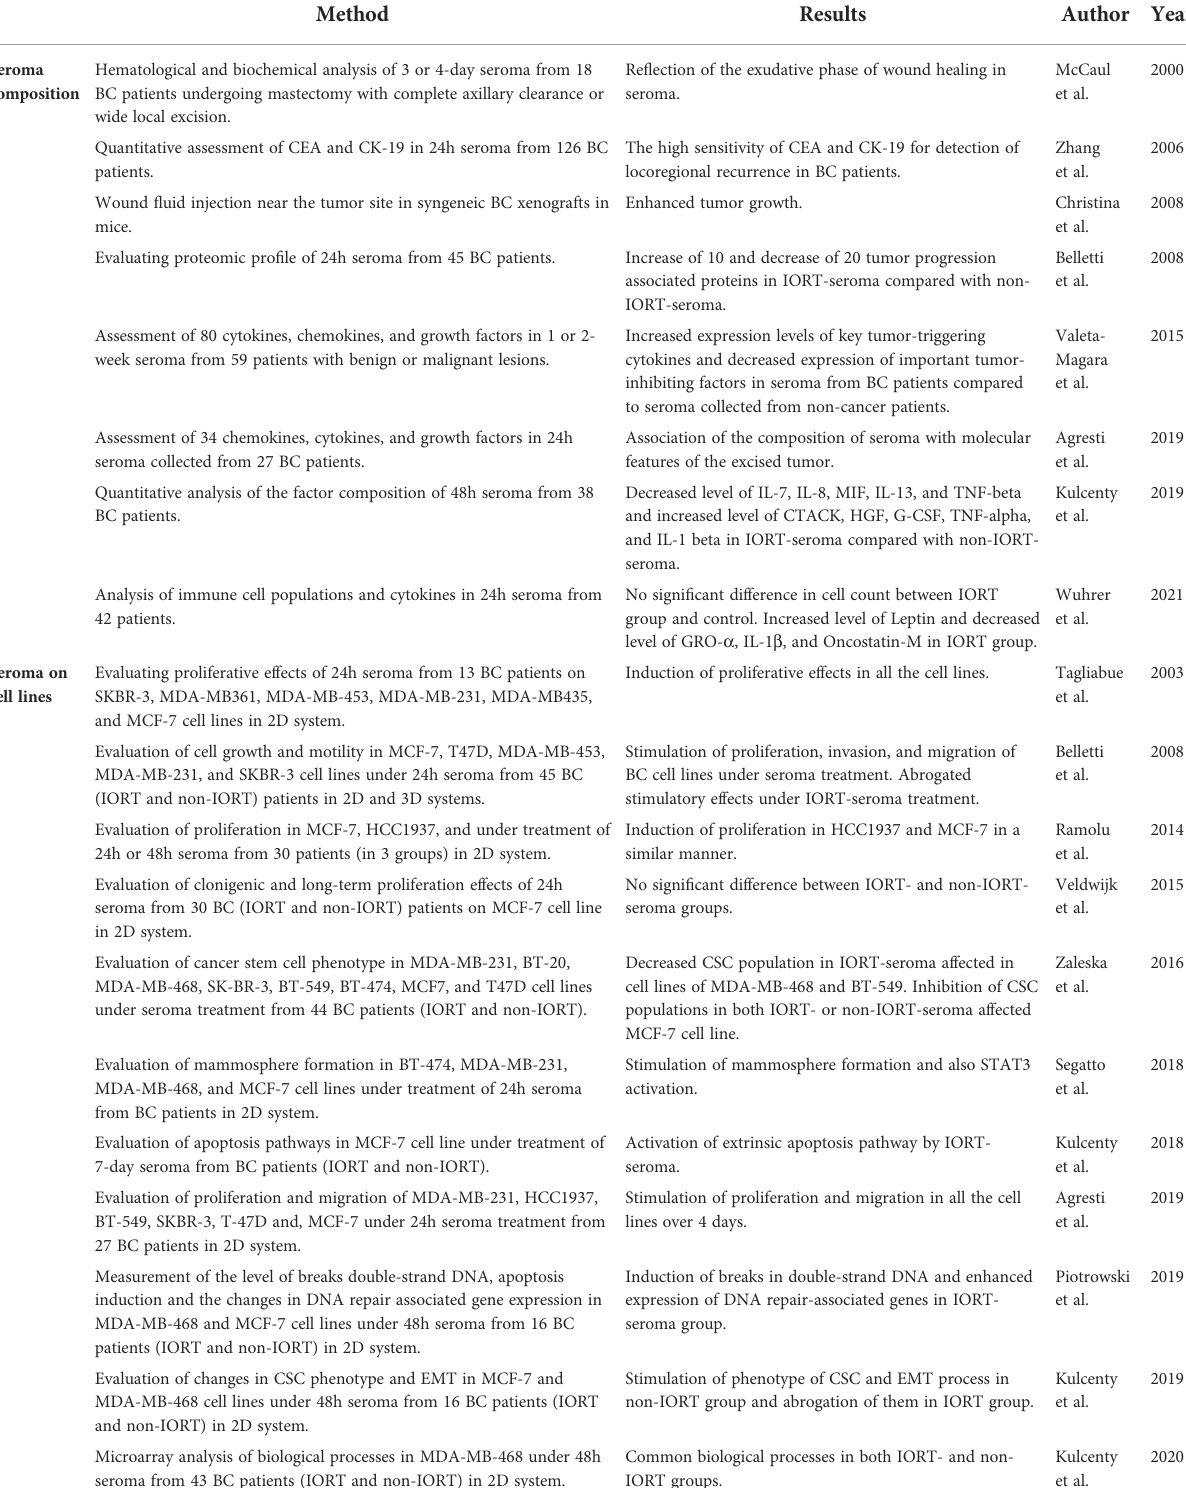
TABLE 2 Summary of studies associated with effects of seroma and IORT-seroma on breast